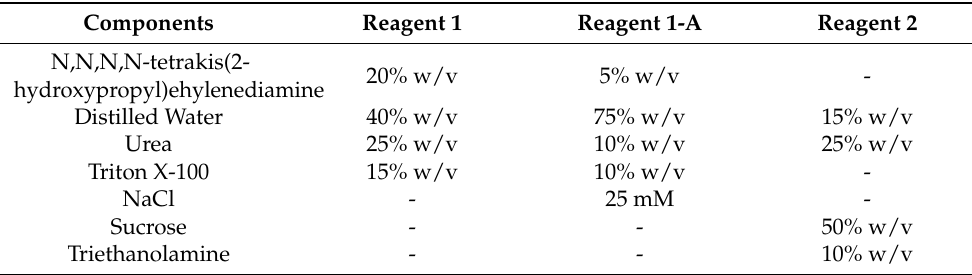
Table 1. Reagent composition for CUBIC protocol for human